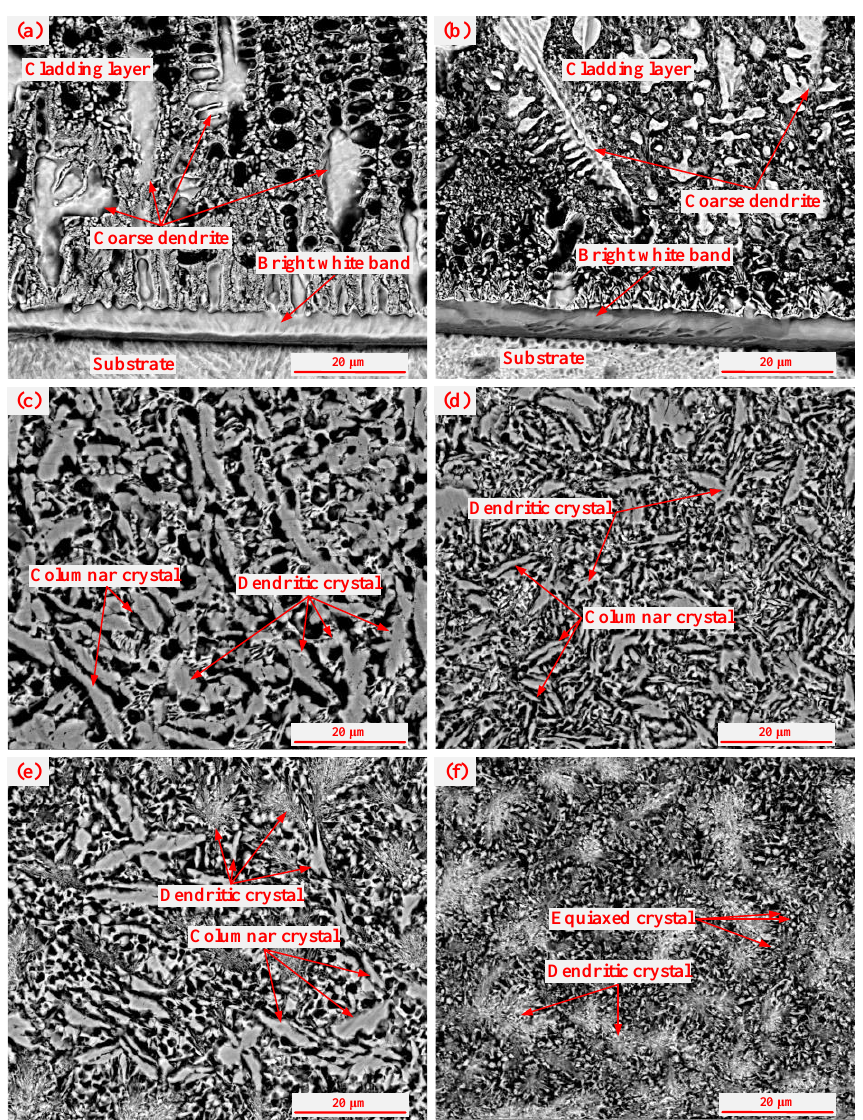
Figure 8. Microstructures of the cladding layers of samples 6 and 7. ( a ) and ( b ) The bottoms of the cladding layers of samples 6 and 7; ( c ) and ( d ) The middles of the cladding layers of samples 6 and 7; ( e ) and ( f ) The upper parts of the cladding layers of samples 6 and 7.